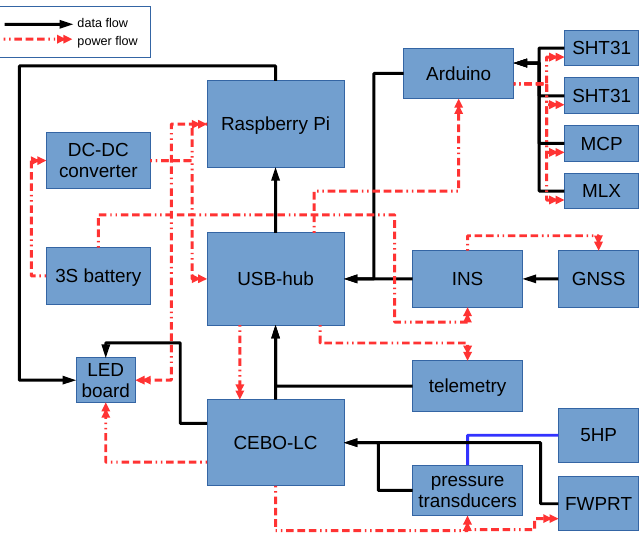
Figure 4. Data and power flow diagram of the MASC-3 sensor